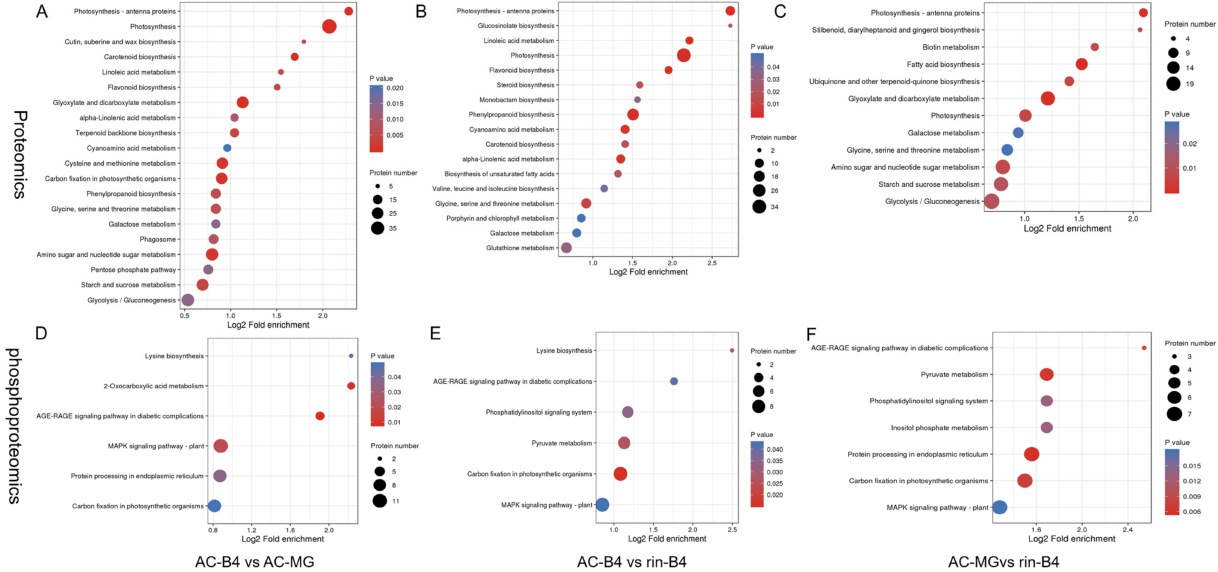
Figure 6. Bubble charts of enrichment distributions of DEPs and DEPPs in KEGG pathways. ( A – C ) Bubble charts of enrichment distributions of DEPs (proteome) in the KEGG pathways of different comparison groups; ( D – F ) Bubble charts of enrichment distributions of DEPPs (phosphoproteome) in KEGG pathways of different comparison